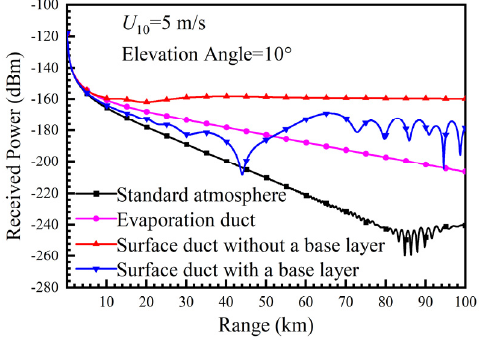
Figure 3. Received powers versus the horizontal distance in a standard atmosphere and horizontally homogeneous tropospheric ducts for ocean-scattered B1I signals.